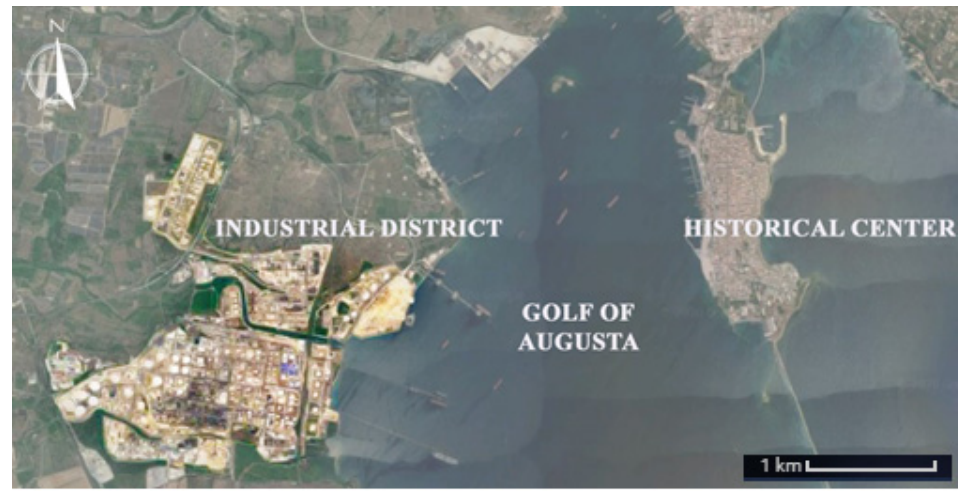
Figure 4. Layout of the studied area (After Google Maps, modified).